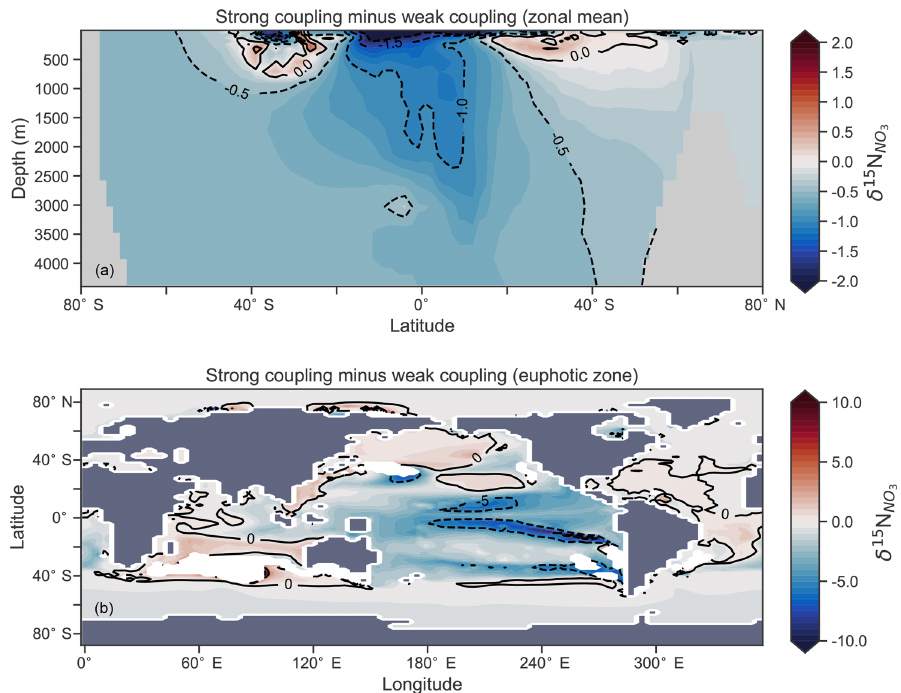
Figure 16. Change in δ 15 N NO caused by a stronger coupling between N 2 fixation and tropical regions of low NO 3 : PO 4 concentrations 3 (i.e. tropical upwelling zones with active water column denitrification). Panel (a) shows the global zonal mean change, while panel (b) shows the average change in the euphotic zone, here defined as the top 100m. Areas with very low NO 3 ( < 0 . 1mmolm − 3 ) are masked